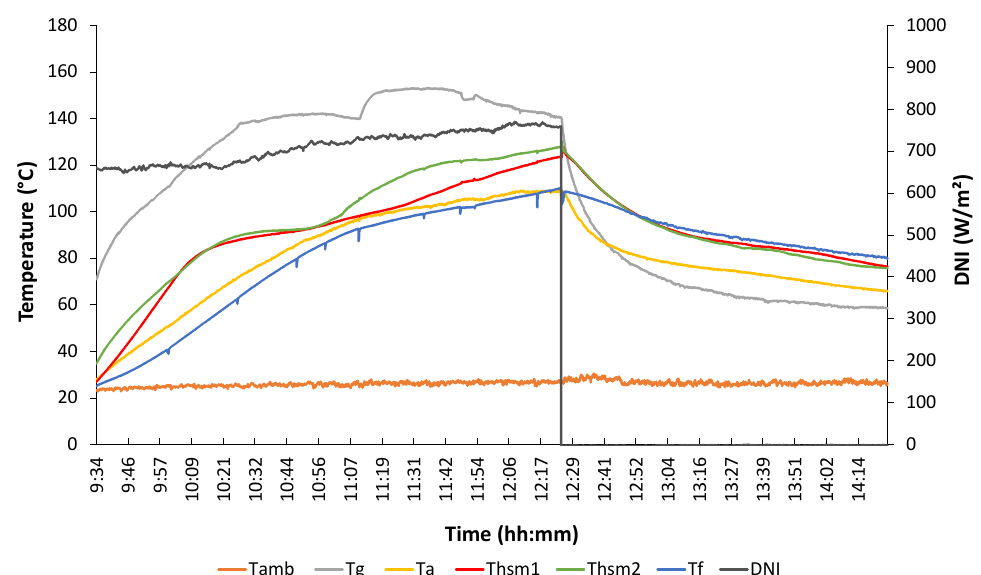
Figure 7. Results of a silicone oil + HSM test without triggering (07/06/2019, test